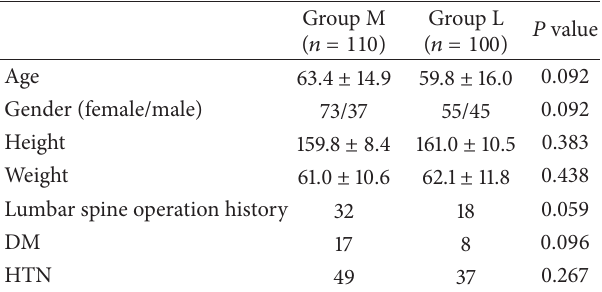
Table 2: Demographic data of the patients treated in group M and group